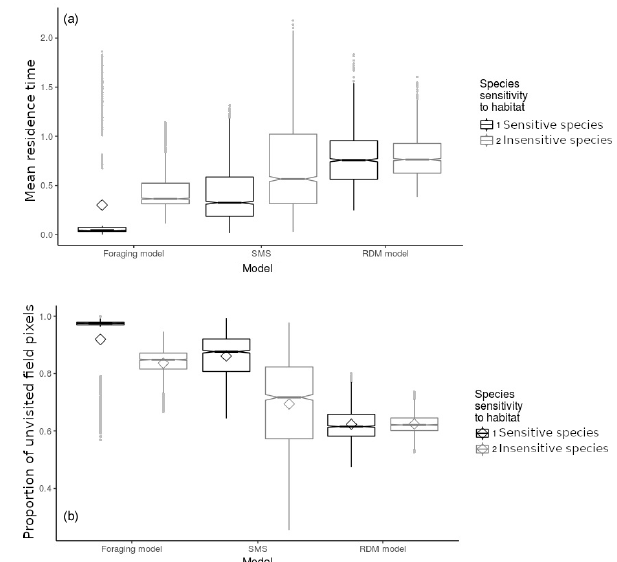
Figure 4. Model and species comparison showing mean field resi- dence time in time steps (ts) per pixel (a) and proportion of unvisited field pixels (b) as a function of model types (foraging model, routine and direct movements model, stochastic movement simulator) and species sensitivity to habitat quality. Diamonds represent the mean; notches represent the 95% confidence interval around the median (which is represented by the horizontal junction between notches); vertical bars represent the 25th and 75th percentiles; grey dots rep- resent outliers. Mean values and error indicators show the models’ sensitivity to particular sets of habitat qualities (for each model and species, values are pooled and summarised from 30 repetitions of landscapes generated stochastically for each set of habitat